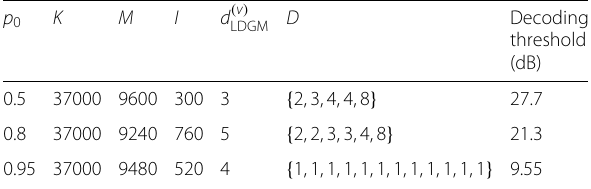
for fast fading Rayleigh channels